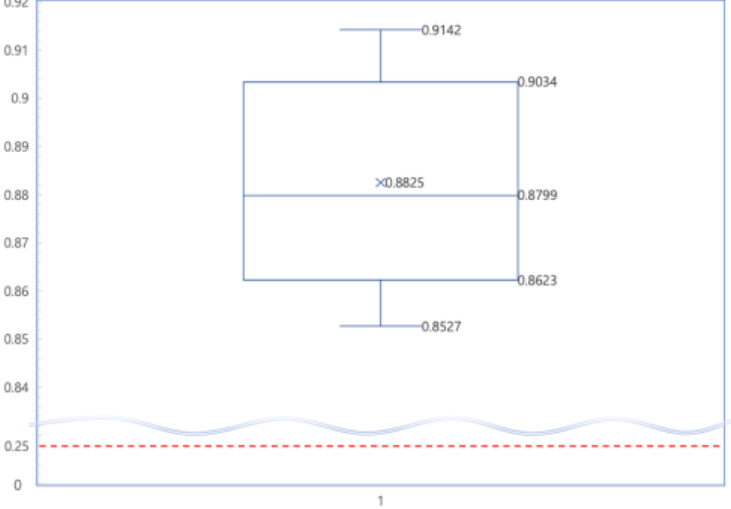
Figure 11. state classification accuracy (chance level accuracy =